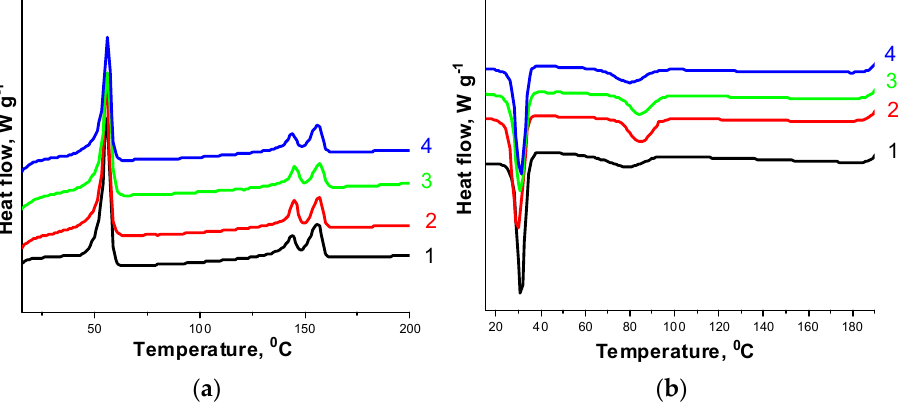
Figure 11. DSC curves for the PHBV/PCL(1:2) mixture (1); PHBV/PCL(1:2)/CNC(PVP)–5 (2), PHBV/PCL(1:2)/CNC(PVP)–10 (3), and PHBV/PCL(1:2)/CNC(PVP)–15 (4) composites: at heating ( a ); at cooling ( b ). Table 2. The temperatures of melting ( T m ), crystallization ( T cryst ), the heat of fusion ( Δ H m ), the de- gree of crystallinity ( χ c ) of PHBV and PCL in mixtures (1:1 and 1:2) and in composites with CNCs.